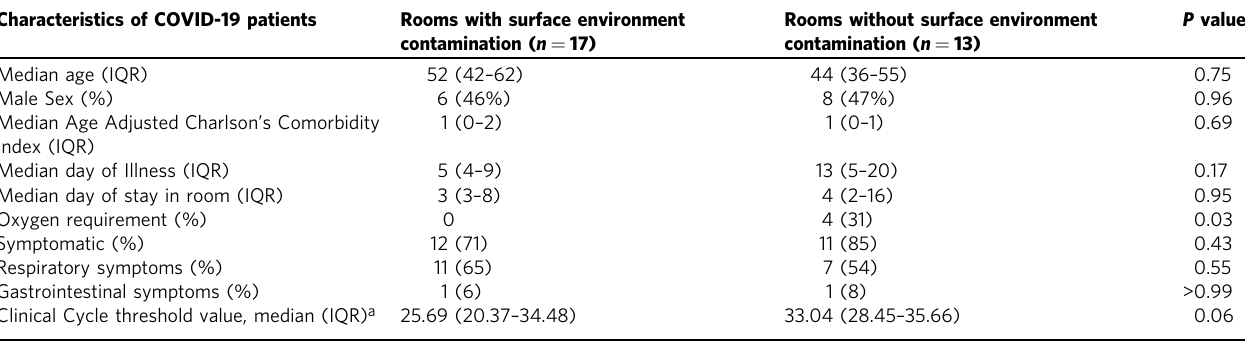
Table 2 Baseline clinical characteristics of COVID-19 patients with environmental contamination. Characteristics of COVID-19